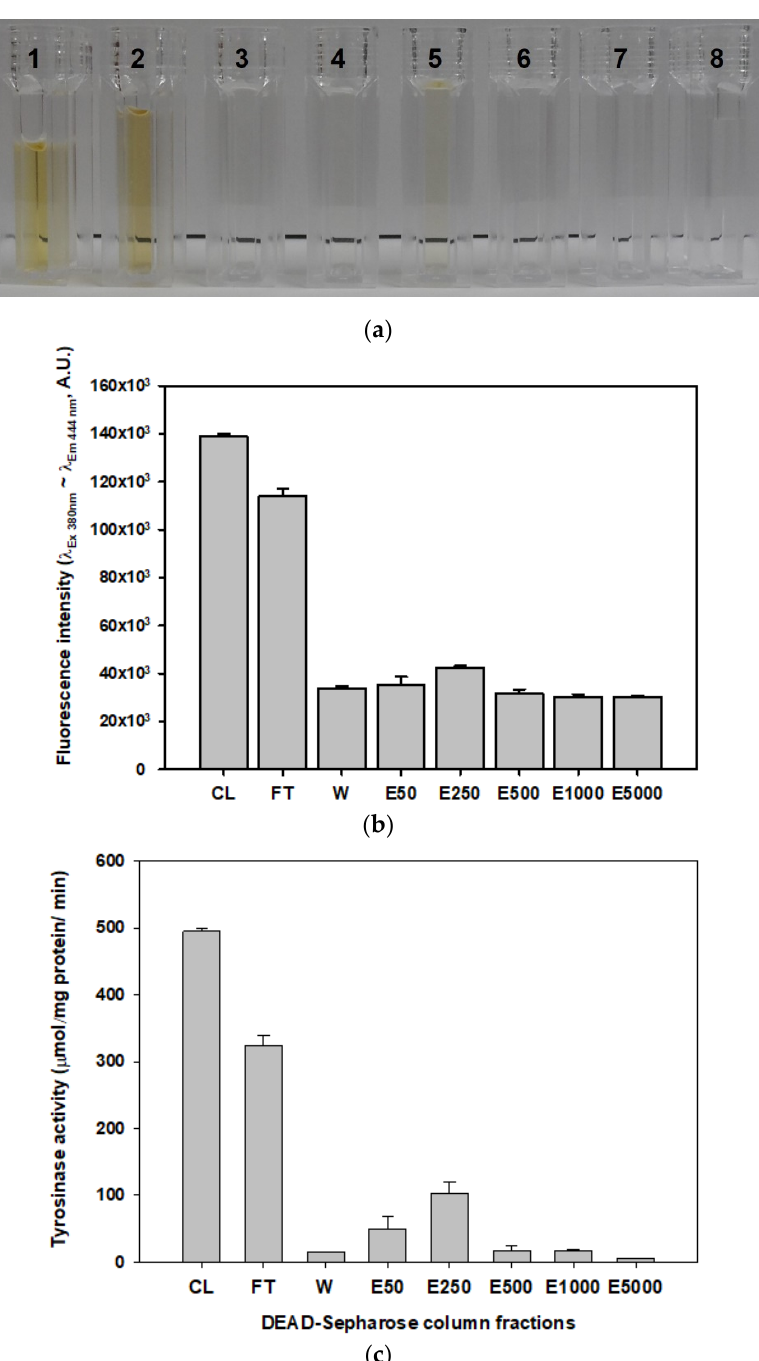
Figure 3. Measurement of the browning pigment substances and tyrosinase activities in the fraction pools collected in the DEAE-Sepharose column. ( a ) The protein fraction pools eluted from the DEAE-Sepharose column: 1, crude extract fraction pool (CL); 2, flow-through fraction pool (FT); 2, wash fraction pool (W); 4–8, elution fraction pools with 50 mM (E50), 250 mM (E250), 500 mM (E500), 1000 mM (E1000), and 5000 mM NaCl (E5000), respectively, in 50 mM Tris-HCl bu ff er. ( b ) Fluorescence intensities (Arbitrary Unit, A.U.) of these fraction pools for the measurement of brown pigment under the optimum conditions with λ Ex380nm ~ λ Em460nm . ( c ) Tyrosinase-specific activities of these fraction pools under the enzyme assay conditions described in the material and method section.